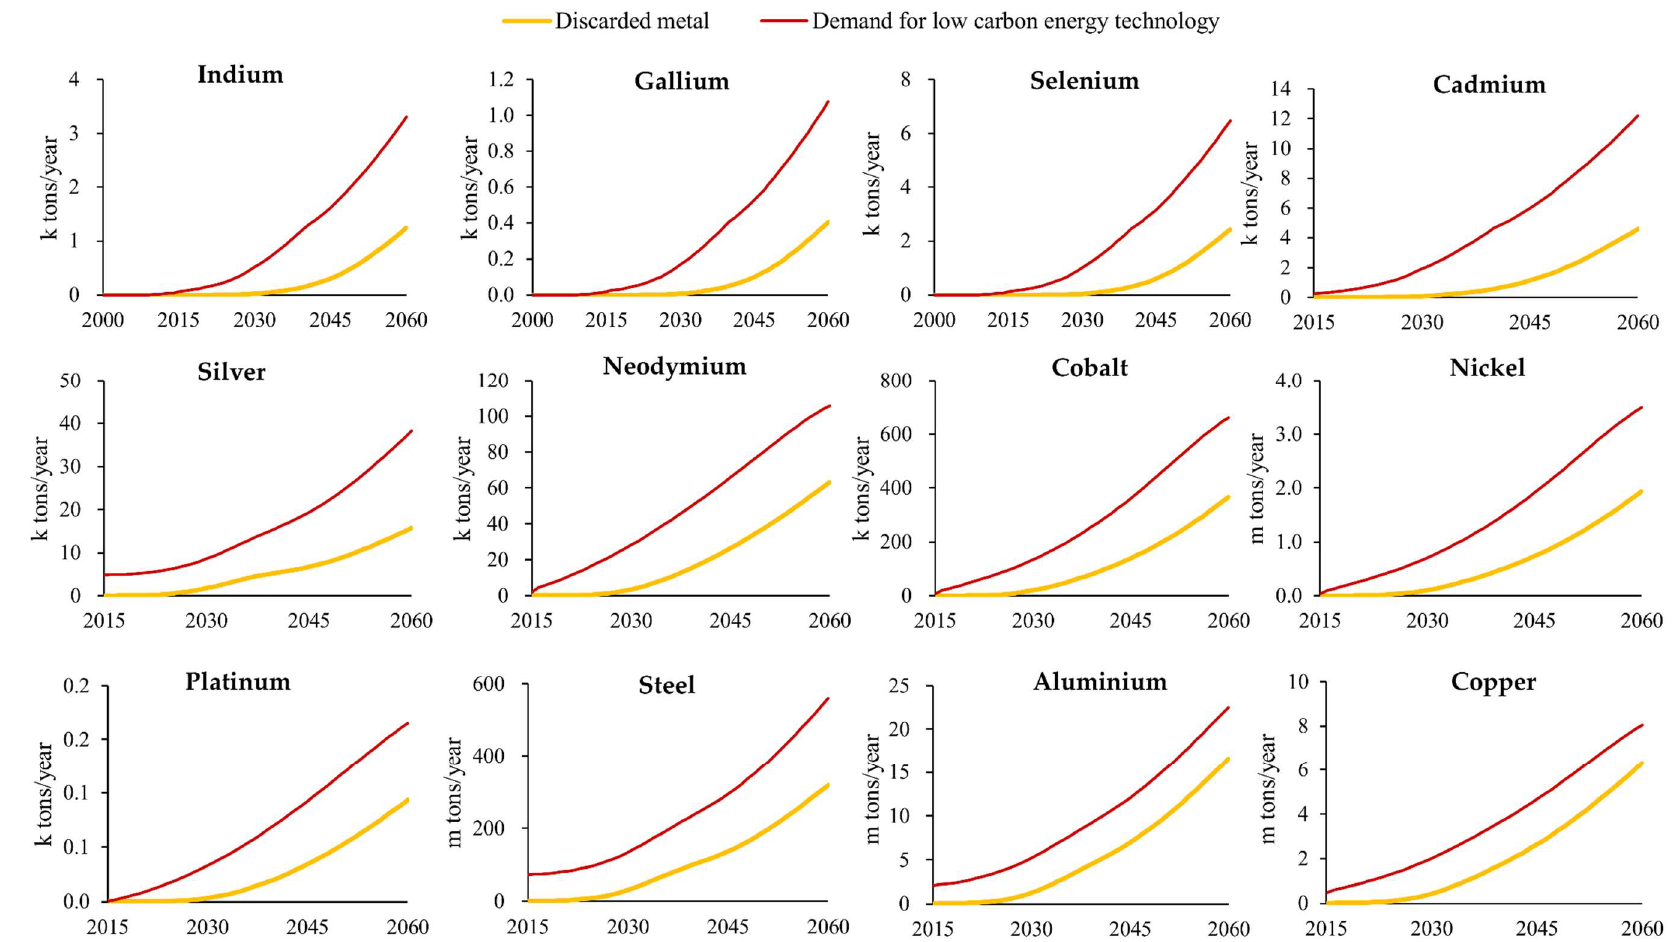
Figure A3. Complete Annual discards of end-of-life material and annual demand for low carbon energy technology (except Te, Dy, Li).